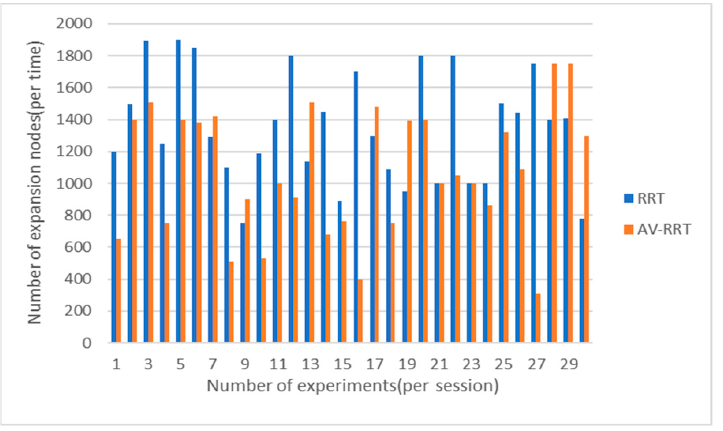
Figure 15. Comparison of number of extended nodes in scene with moderate obstacles.